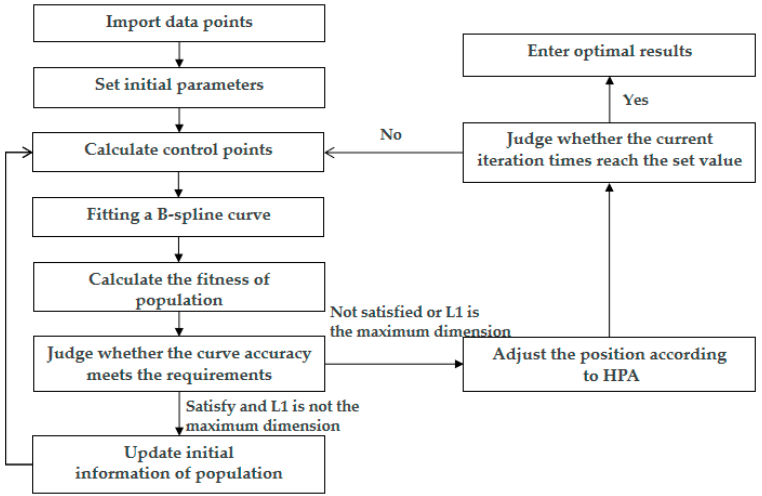
Figure 5. Algorithm flow of HPA .